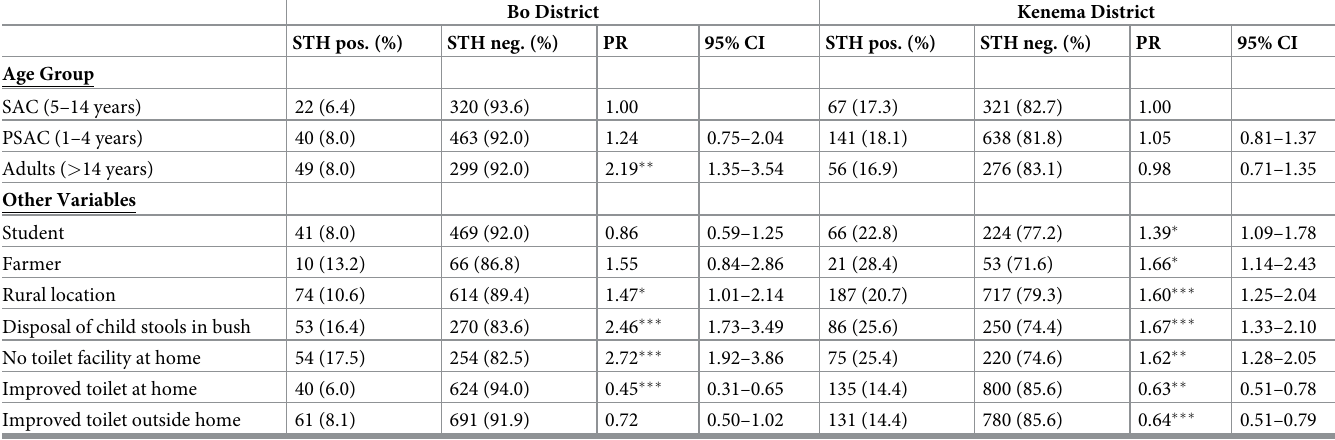
Table 3. Distribution of soil transmitted helminthiasis cases (any species) and crude prevalence ratios for variables independently associated with infection, both